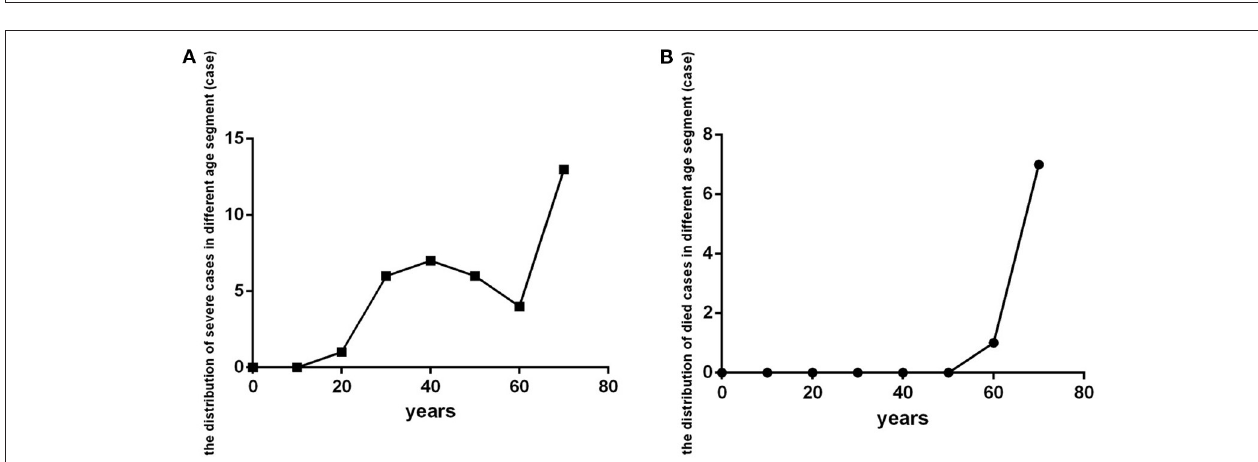
FIGURE 4 | The distribution characteristics of the number of comorbidities and clinical type among COVID-19 patients ( n = 718). COVID-19, coronavirus disease 2019. (A) Number of comorbidities. (B) Clinical type.